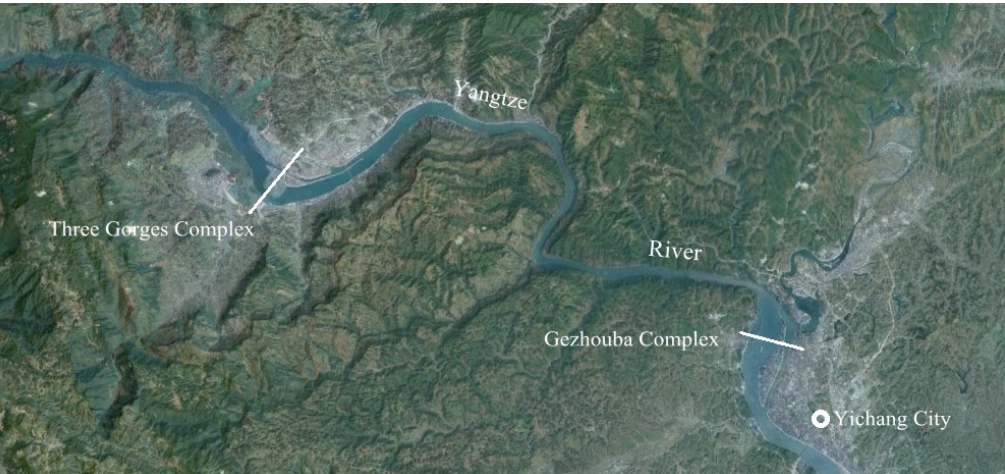
Figure 1. Location of the Three Gorges and Gezhouba Cascade Complex, adapted from [8].